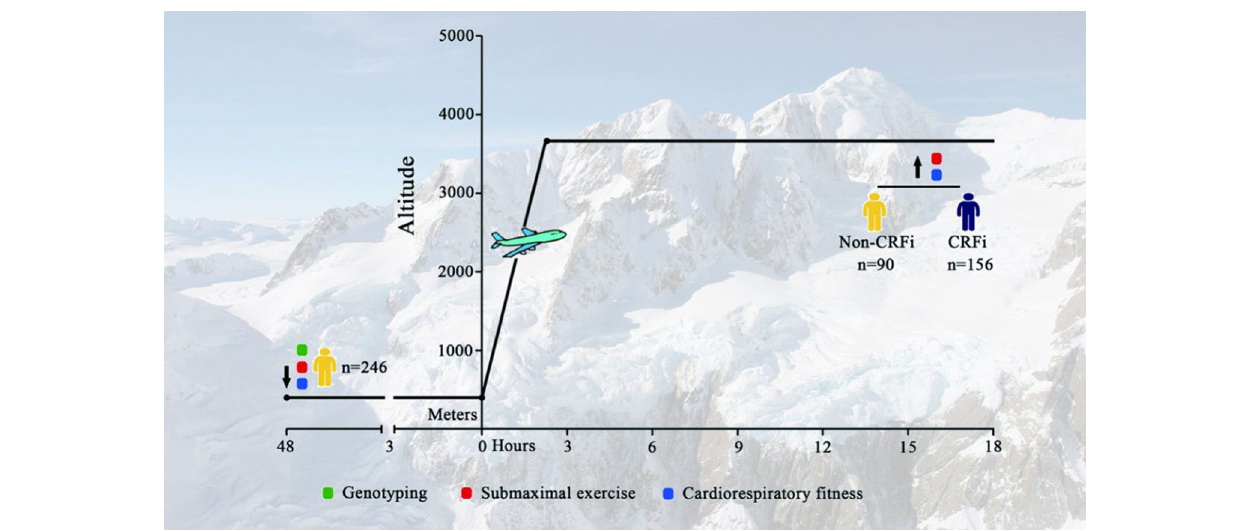
FIGURE 1 | Timeline for assessment. Subjects were transported to Lhasa [HA, 3,700m above the sea level (asl)] from Chengdu (SL < 500m) through an airplane. Physiological parameters, including SpO 2 , SBP, DBP, and HR, at SL and HA were collected. Submaximal exercise and cardiorespiratory fitness tests were performed at SL and HA (red and blue circles, respectively). Demographic data and genetic information were obtained at SL before departure (green circle). HA, high-altitude; SL, sea level; SpO 2 , oxygen saturation; SBP, systolic blood pressure; DBP, diastolic blood pressure; HR, heart rate; CRF, cardiorespiratory fitness impairment.